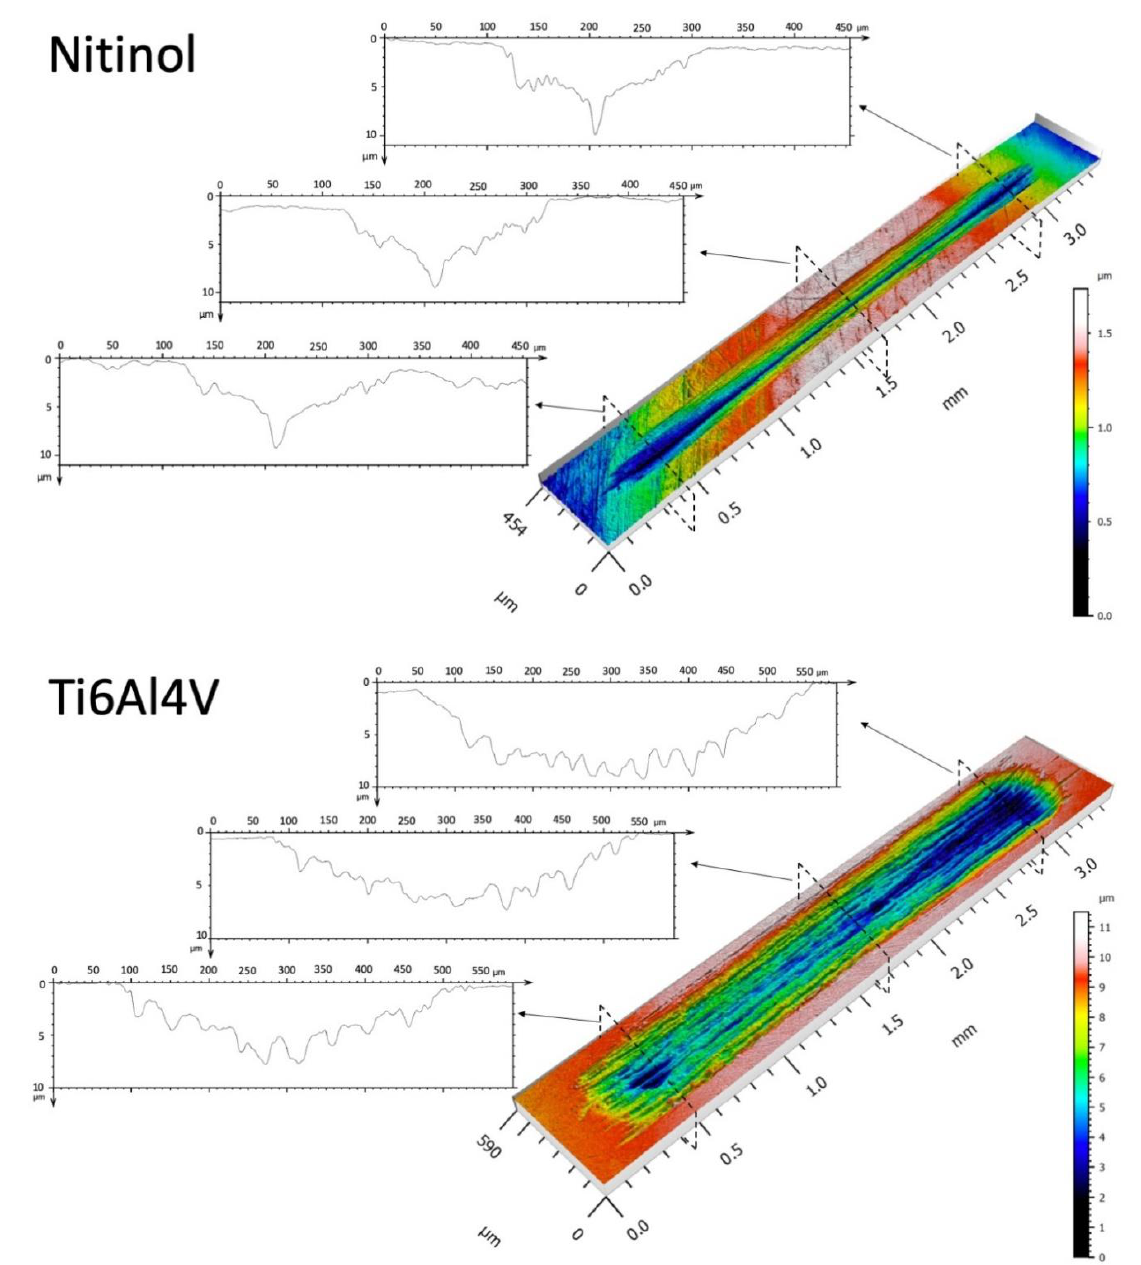
Figure 4. Surface topography images of the wear tracks and also the worn surface profiles (three different zones) for LB-DED NiTi and Ti-6Al-4V alloys.